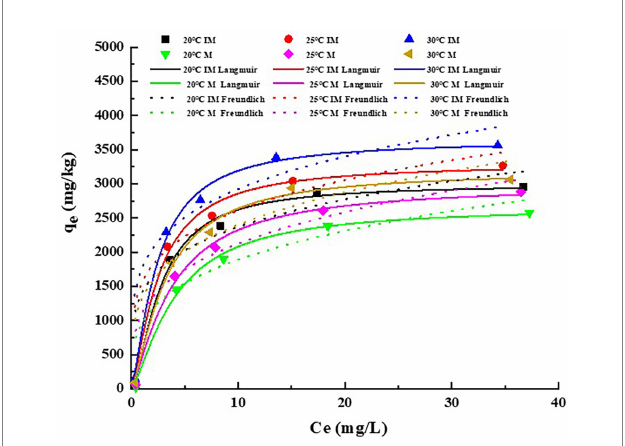
FIGURE 3 Adsorption isotherms plots of atrazine on carrier materials (M) and immobilized carrier materials (IM). q e represents the adsorption capacity of M and IM in equilibrium at different